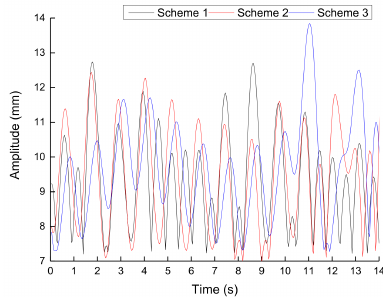
Figure 14. Amplitude change when h = 10 cm.